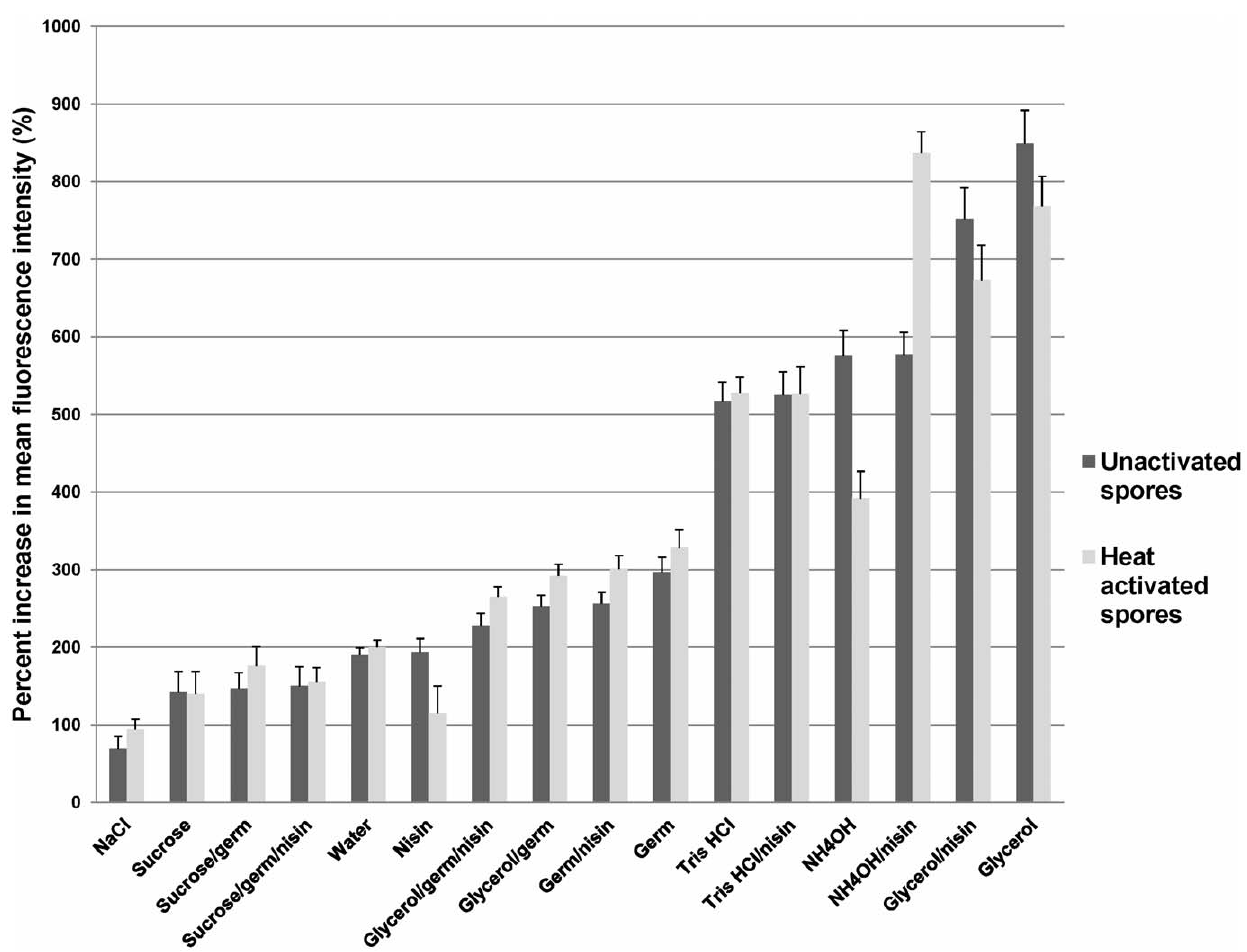
Figure 4. Evidence for membrane integrity as mechanism of inhibition by nisin and osmotic activation. The percent increase in the uptake of propidium iodide (PI) in C. difficile spores was assessed by flow cytometry. The mean fluorescence intensity was determined for each sample and compared to a baseline that did not contain PI. Loss of membrane integrity is inferred by increases in the mean fluorescence intensity as PI passes into the spore. The means of the data from experiments conducted in triplicate are presented. Error bars indicate standard